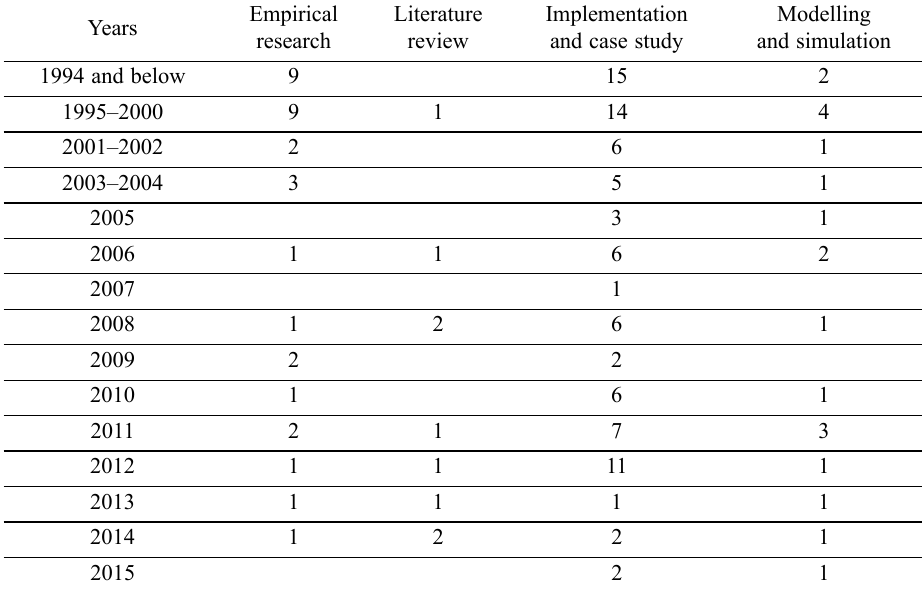
Table 1. Classification of research papers on